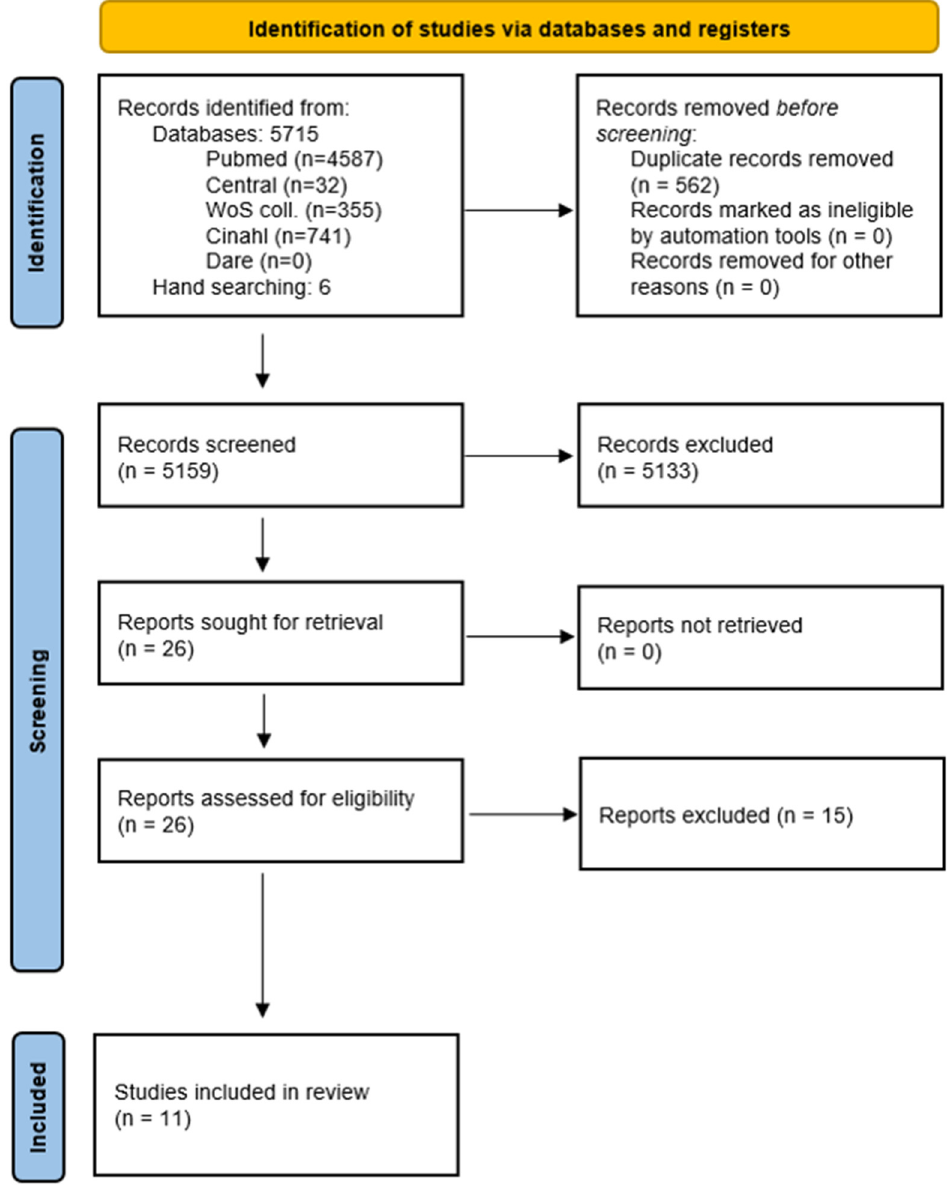
Figure 1. PRISMA flowchart.